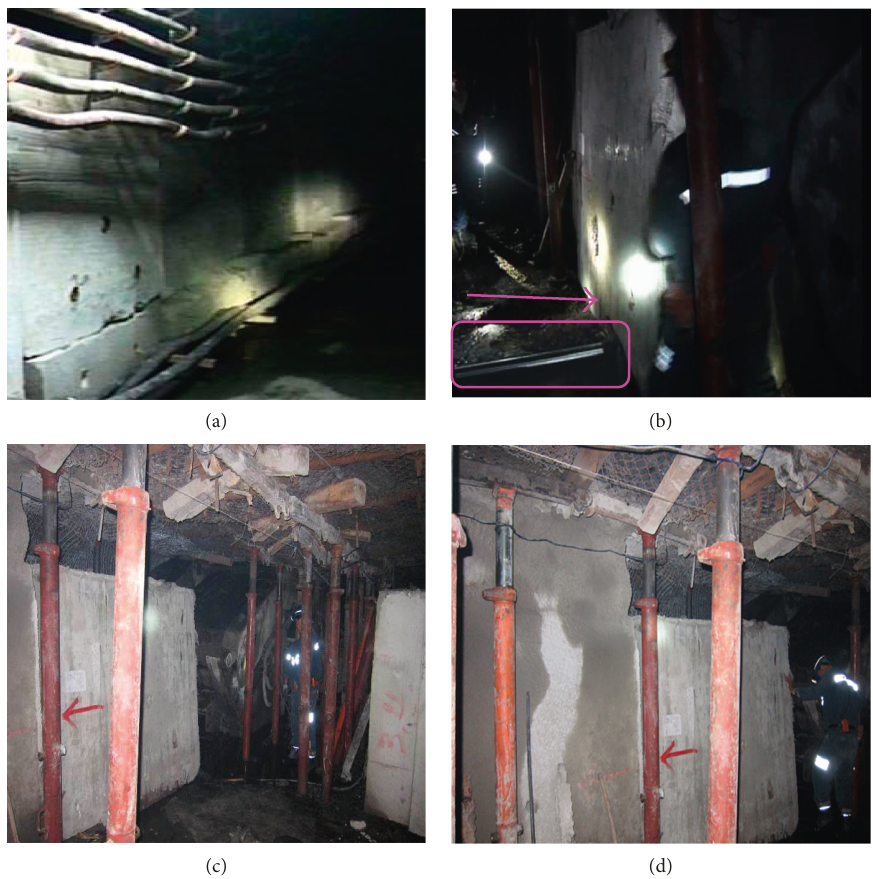
Figure 15: Pictures of the gob-side entry retaining artificial wall construction: (a) initial placement of a block; (b) position adjustment by the hydraulic prop; (c) final position of the block; (d) connection with the roof of the